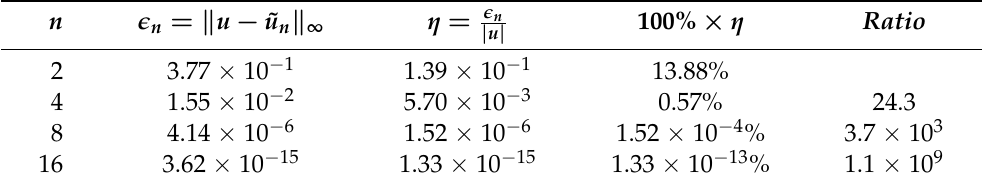
Table 3. IE (48), λ A = 2. DKM: Taylor